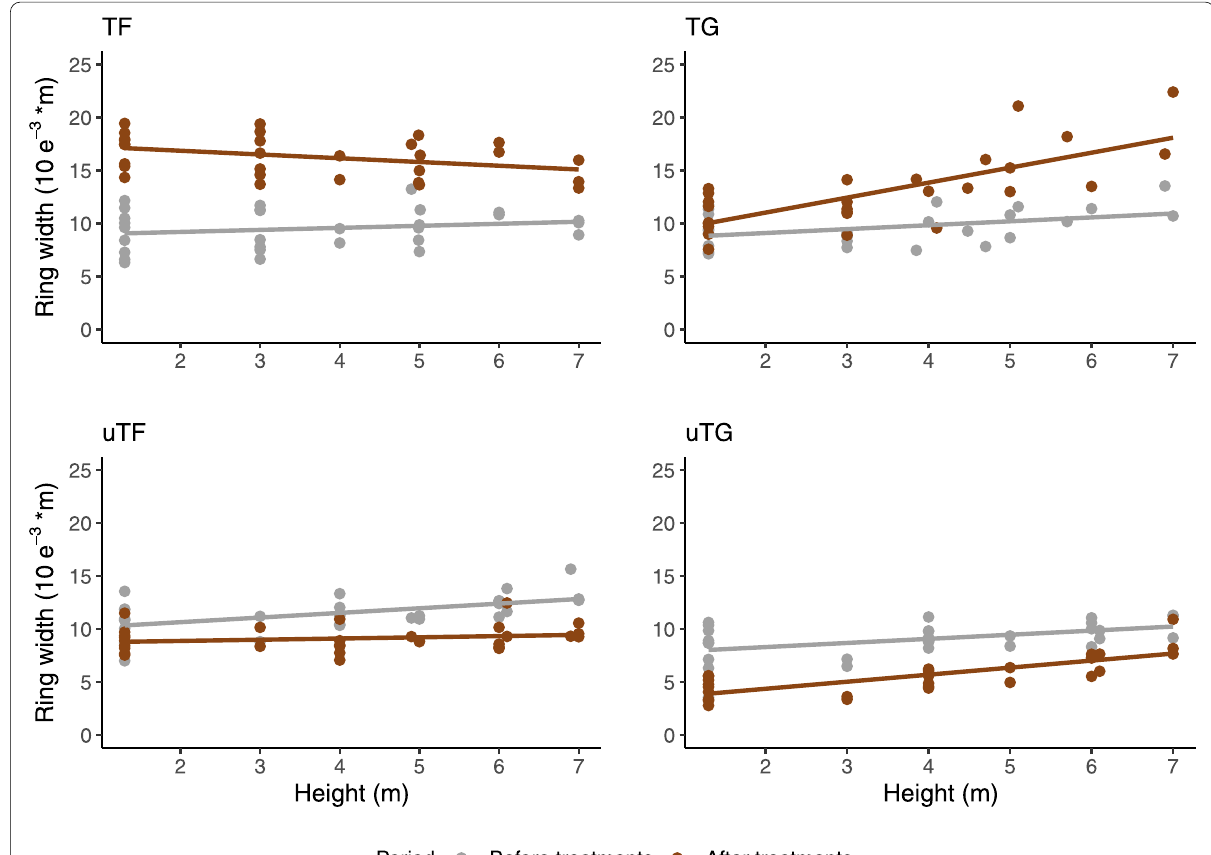
Fig. 3 Variation in ring width below the guy rope related to tree height before and after thinning. TF stands for thinned free-swaying trees, TG for thinned guy-wired trees, uTF for unthinned free-swaying trees and uTG for unthinned guy-wired